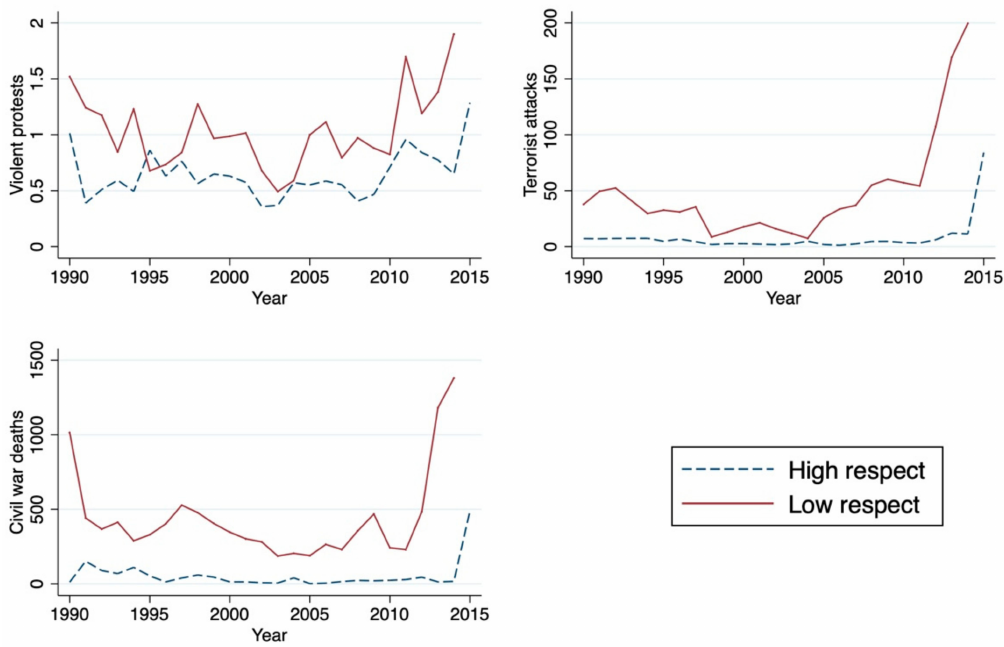
Figure 1. Respect for physical integrity rights and